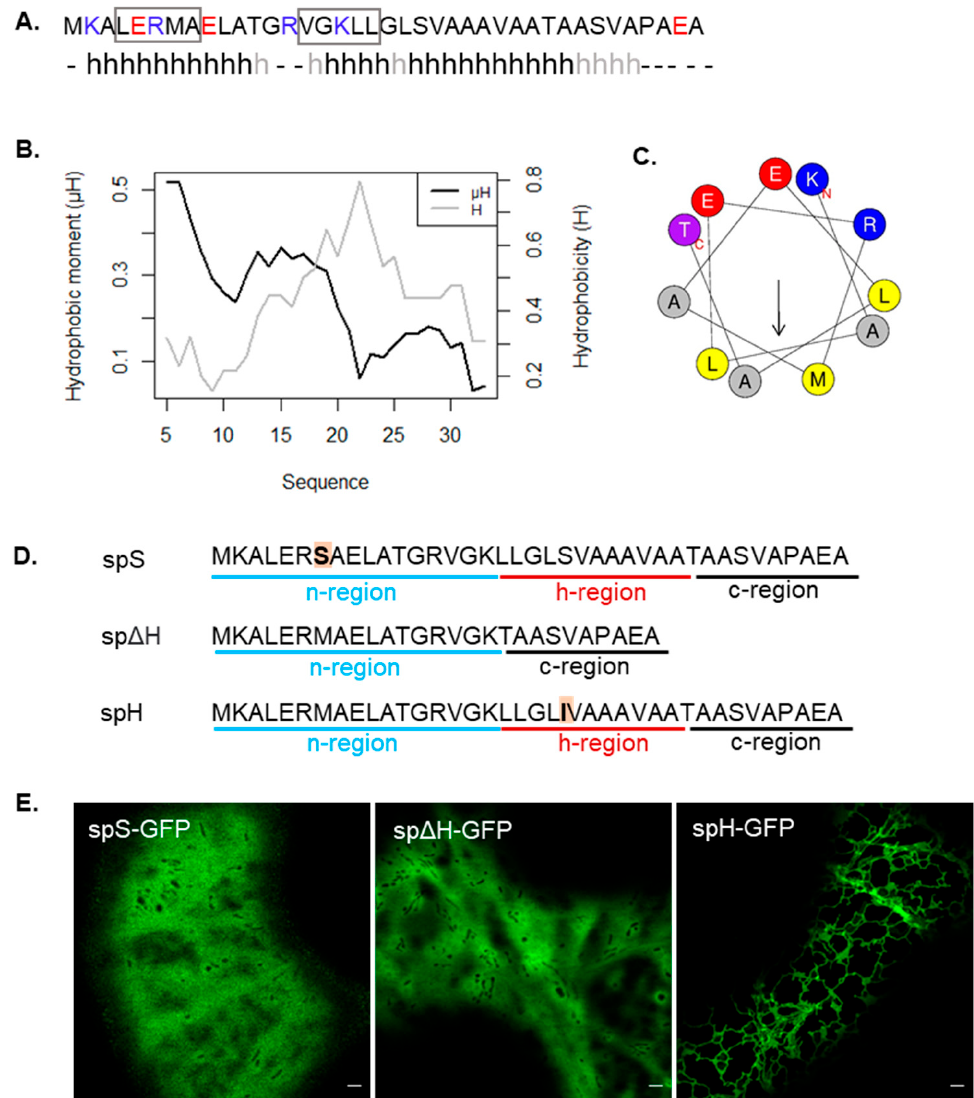
Figure 2. Prediction of an N-terminal amphipathic helix in silico and signal peptide mutations impairing mitochondrial targeting. ( A ) Secondary structure prediction using Jpred 4 and PSIPRED 4.0. An h denotes helical conformation predicted by both software approaches, and light grey h prediction as helix only by PSIPRED 4.0. Basic amino acids are marked in blue, and acidic amino acids are marked in red. The two hydrophobic motifs predicted by MitoFates are highlighted using a rectangle. ( B ) Hydrophobic moment and hydrophobicity of 11 residue windows using HeliQuest. ( C ) Helical wheel diagram of the first 11 residues predicted as an α -helix showing a high hydrophobic moment. ( D ) Sequences of the signal peptide mutants generated. ( E ) Transient expression of mutants in tobacco cells with localisation of spS-GFP and sp ∆ H-GFP to the cytosol, and localisation of spH-GFP to the ER. Scale bar = 2 µ